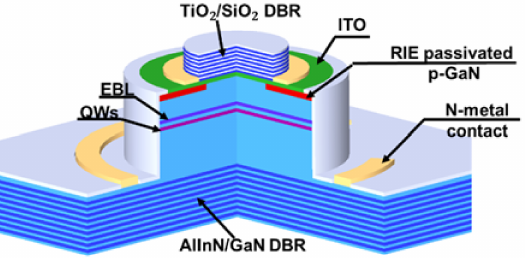
Figure 6. Schematic structure of first hybrid-type VCSEL with AlInN/GaN DBR.